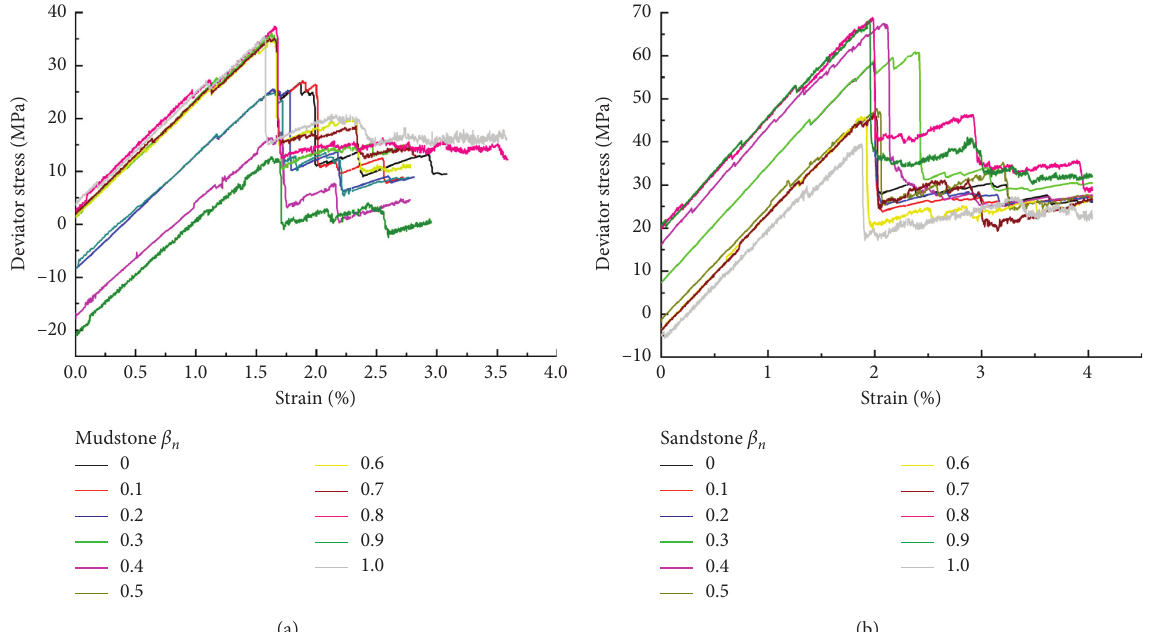
Figure 10: Two kinds of rock stress-strain curves under different β